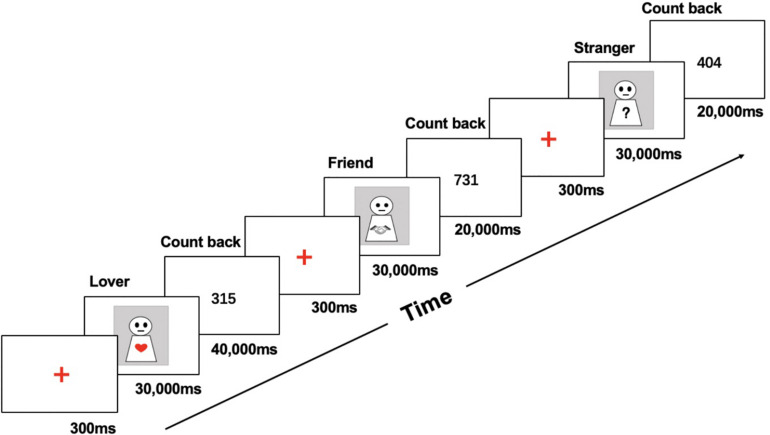
Experimental procedure.